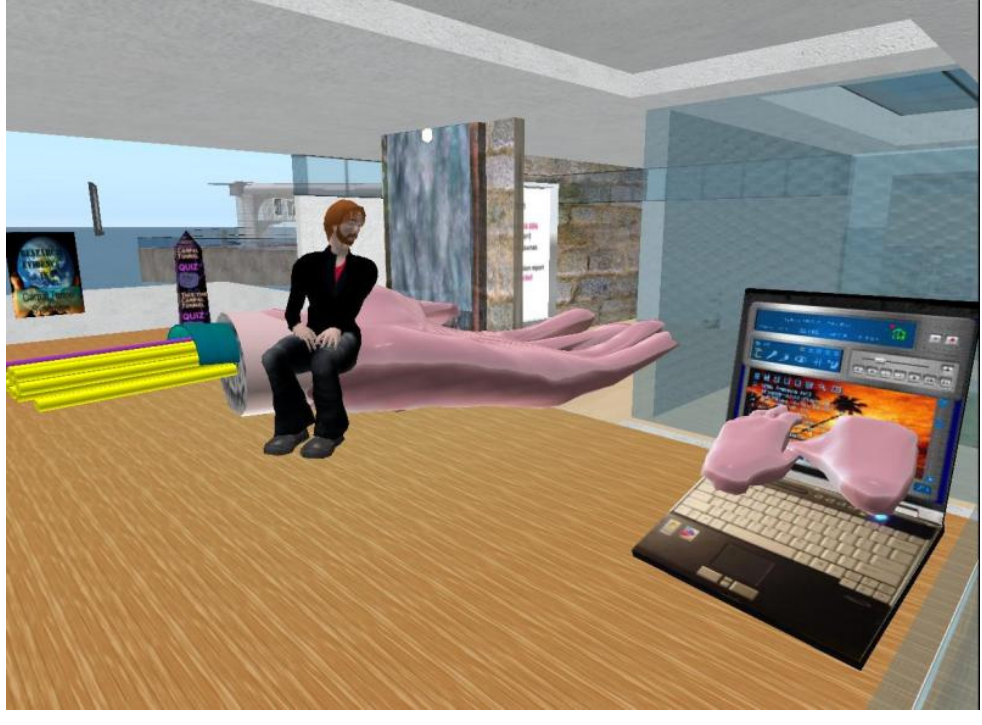
Figure 10 . Carpal tunnel exhibit (snapshot by SL:Knoh